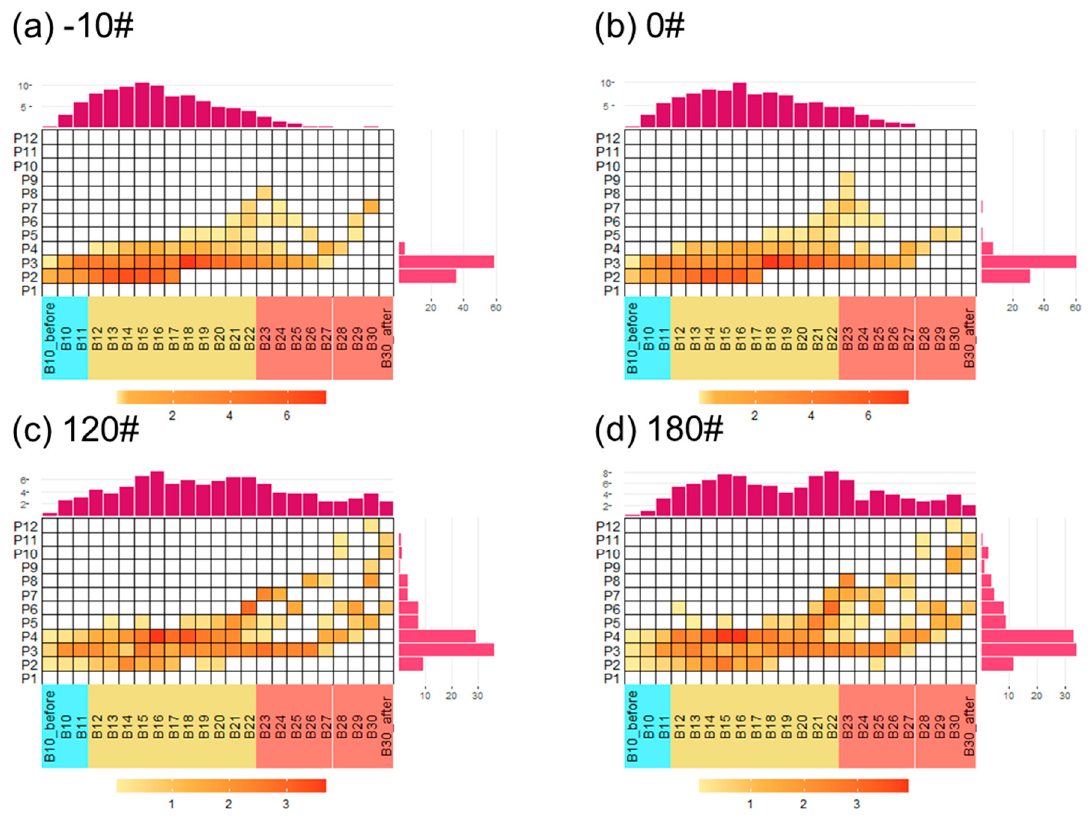
Figure 5. Average volatility-polarity distribution of ( a ) -10#, ( b ) 0#, ( c ) 120#, and ( d ) 180# marine fuel oils. Blue, orange, and red color blocks represent VOCs, IVOCs, and SVOCs with decreasing volatility. Polarity distribution was shown on the y-axis, with increasing polarity from P1–P12. Note that the values shown here all represent mass percentages.